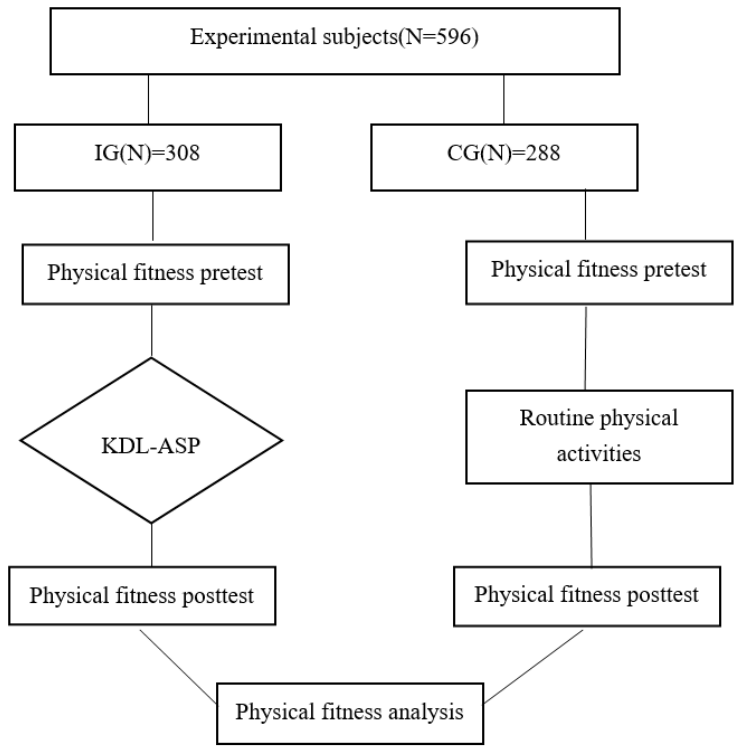
Figure 2. Flow chart of the experiment.